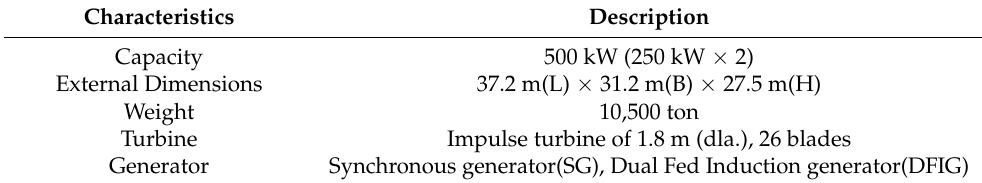
Figure 1. Yongsu OWC–WEC: ( a ) Location map; ( b ) Construction diagram; ( c ) Arrangement for operation; ( d ) Sensors in the turbine. Table 1. Main characteristics of Yongsu OWC–WEC .